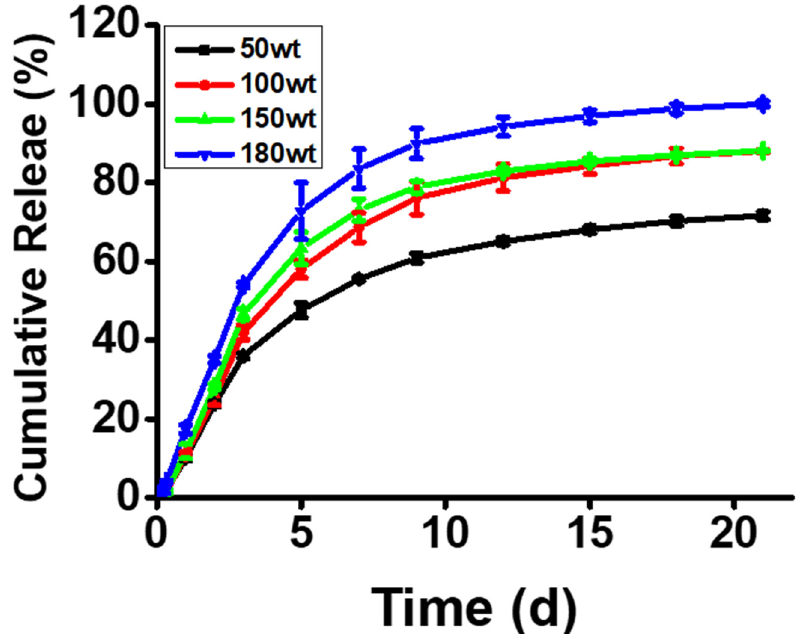
Figure 4. In vitro PTX release profiles from PTX@TNPs with different loading contents in phosphate- buffered saline (PBS, pH 7.4) containing 0.5% ( v / v ) Tween 80. The release was performed under gentle stirring and at 37 °C, and the analysis was performed via high-performance liquid chromatography (HPLC).